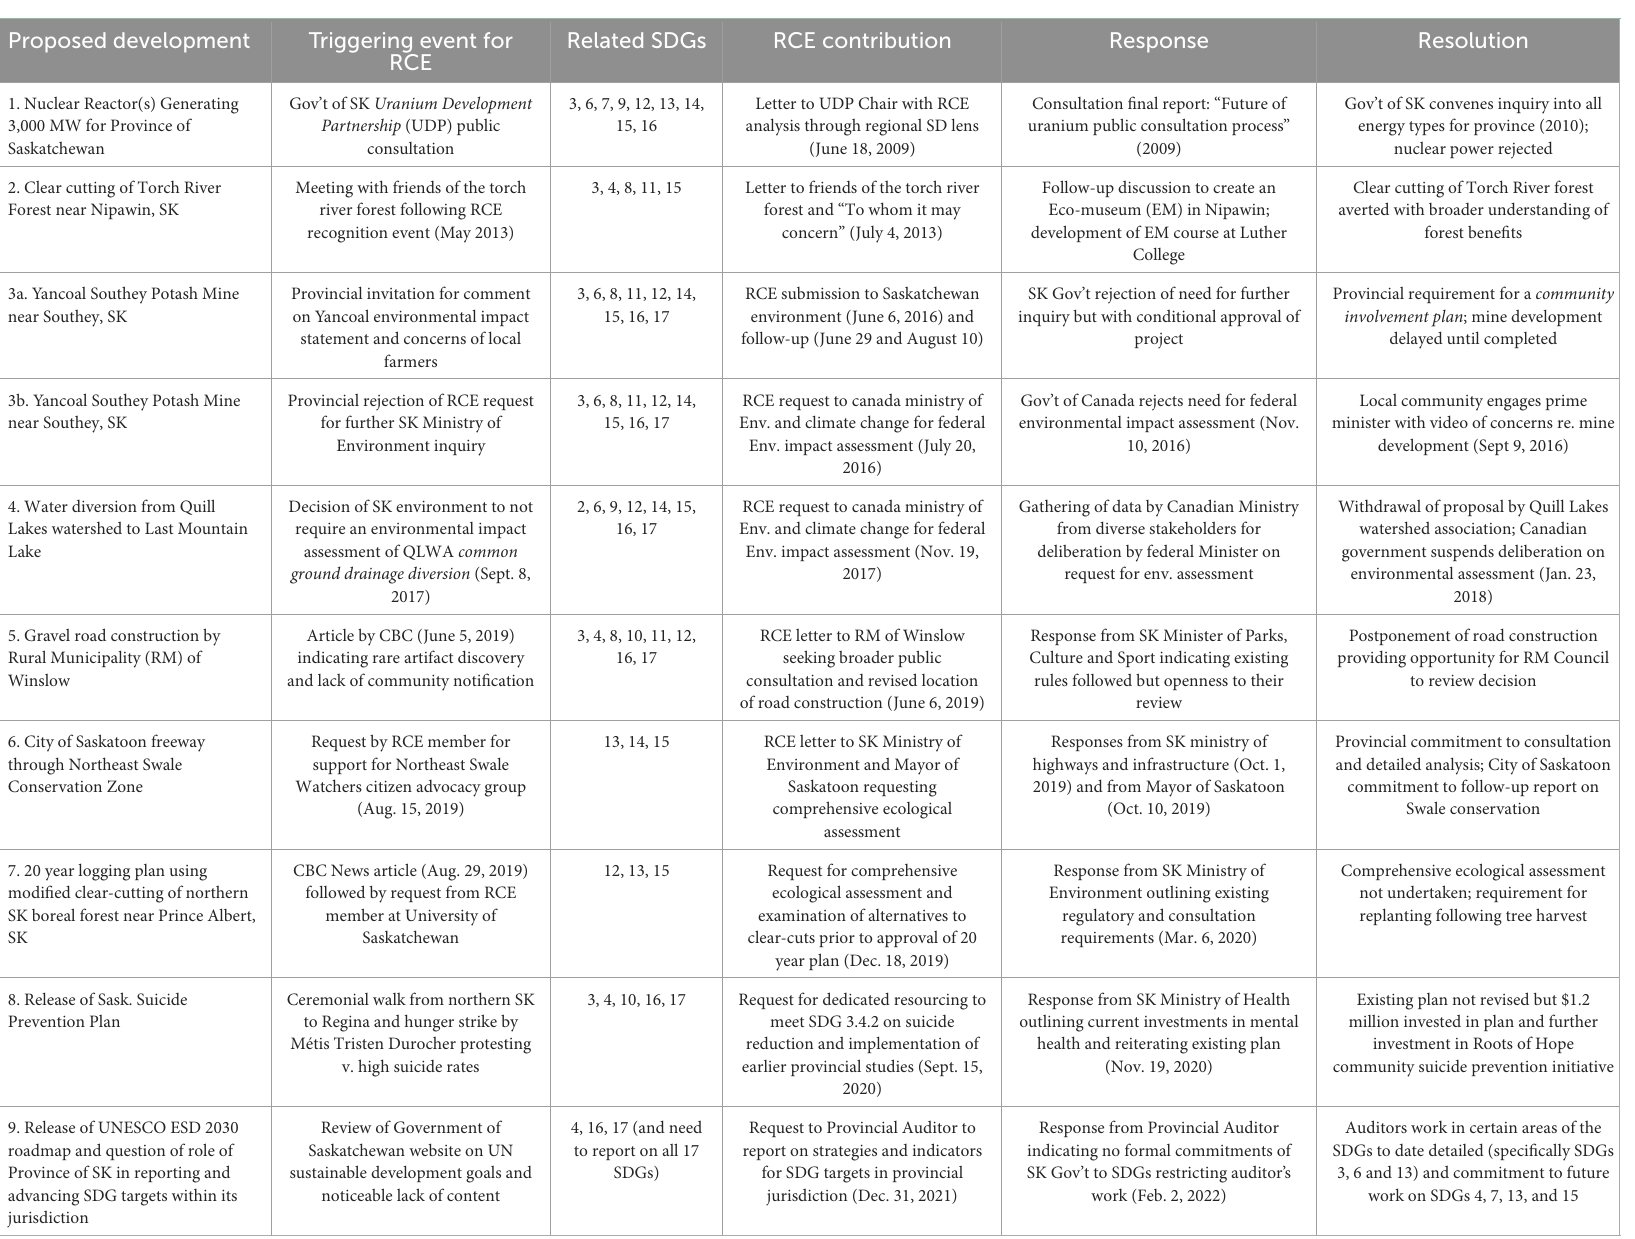
TABLE 1 Select RCE Saskatchewan government correspondence